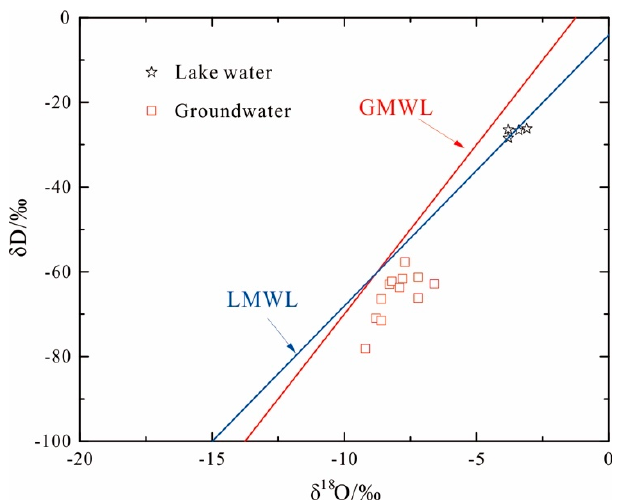
Figure 5. Plot of δ D and δ 18 O of groundwater and lake water.